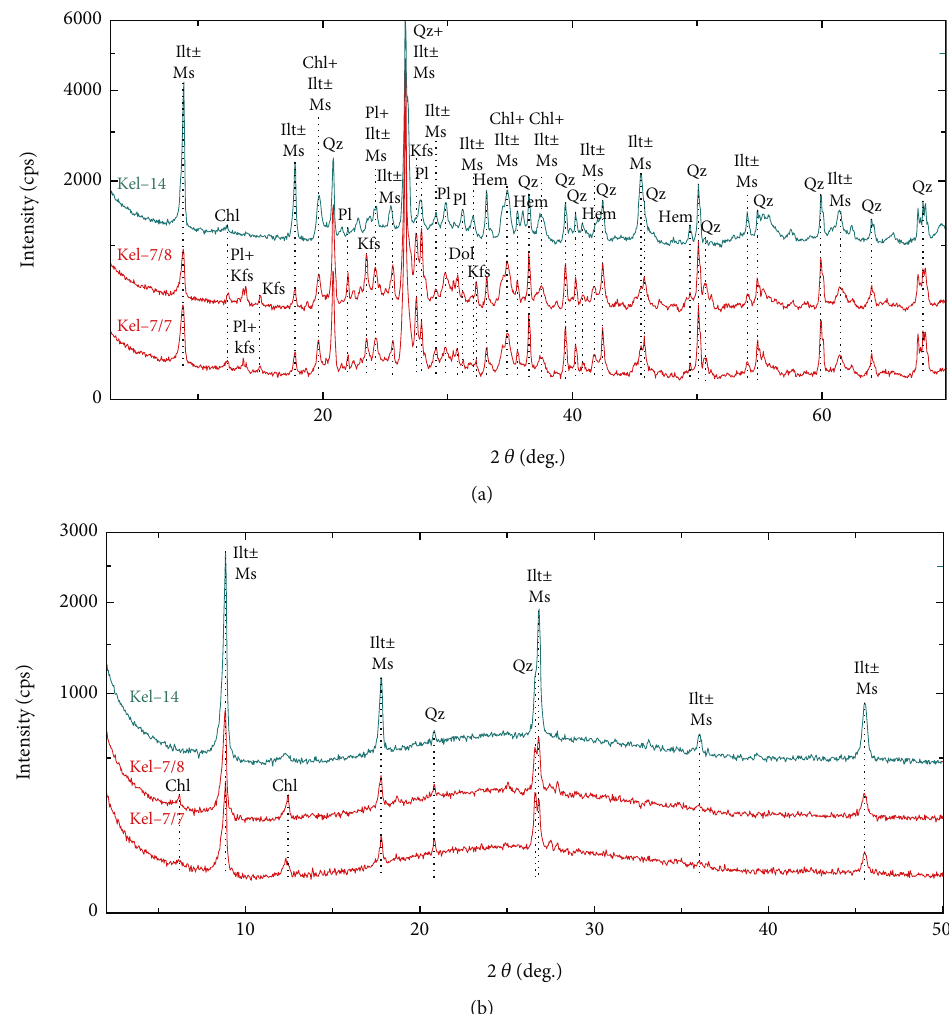
Figure 3: X-ray powder di ff ractograms of the studied samples (sample Kel – 14: Permian red beds; samples Kel – 7/7 and 7/8: Gy ű r ű f ű ignimbrites; for further information, see Table 1). (a) XRPD pattern of the bulk rock samples; (b) XRPD pattern of the separated clay fraction samples (air-dry). Abbreviations: Chl: chlorite; Dol: dolomite; Hem: hematite; Ilt ± Ms: illite ± muscovite; Kfs: K-feldspar; Pl: plagioclase; Qz: